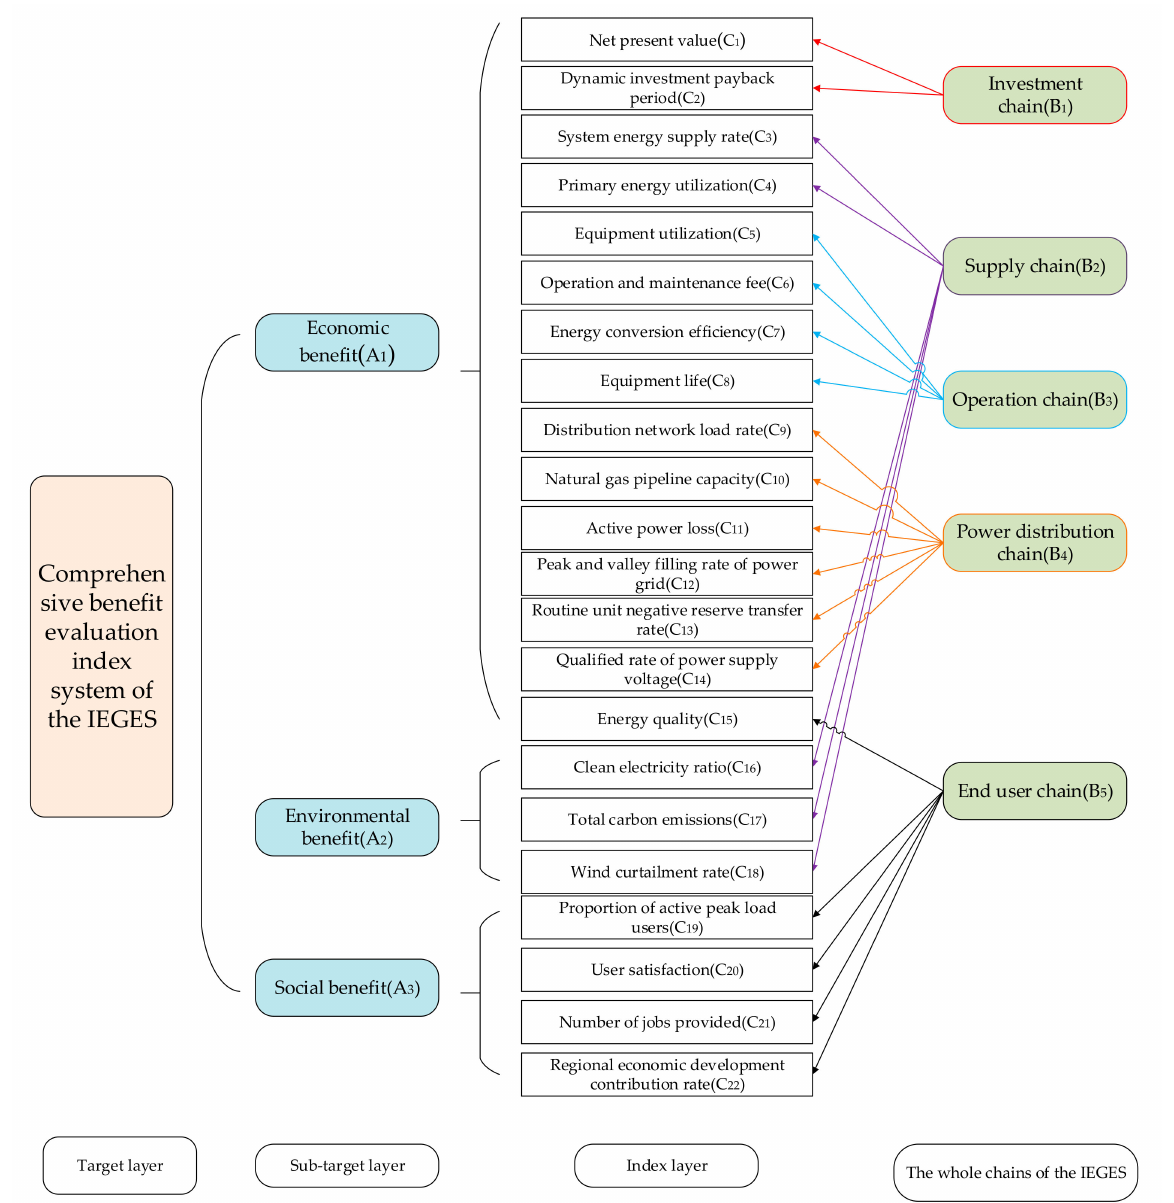
Figure 2. The comprehensive benefit evaluation indicator system of the